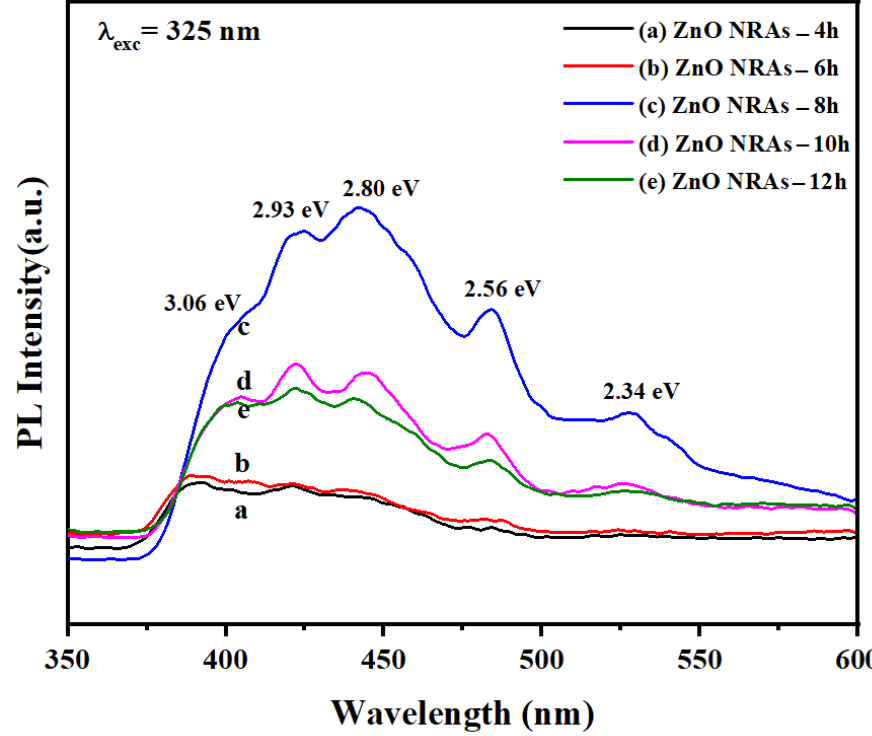
Figure 7. PL spectra of ZNRAs prepared at various hydrothermal growth times.